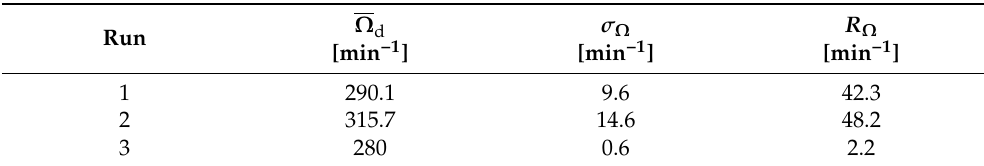
Figure 23. Influence of the operating speed: The dominant frequency peak at 2 ω m,HS for different speed profiles and comparison of measurement (grey) and hybrid approach (black) results for the response spectra at the reference position R in a frequency range of 1000 π rads −1 . Of particular c around the peak, where c = 4 π N interest is the frequency range 2 ω m,HS 2 σ Ω accounts 60smin − 1 ± · for the transformation from operational speed to the second order meshing frequency of the HS stage. Despite a negative offset for run 1 and 2, the model results are in good agreement with the measurement results regarding the position, width and relative shape of the dominant frequency peak. Table 2. Operating speeds Ω d of the HS stage during measurement runs 1–3, regarding mean value Ω d , standard derivation σ Ω , and range R Ω